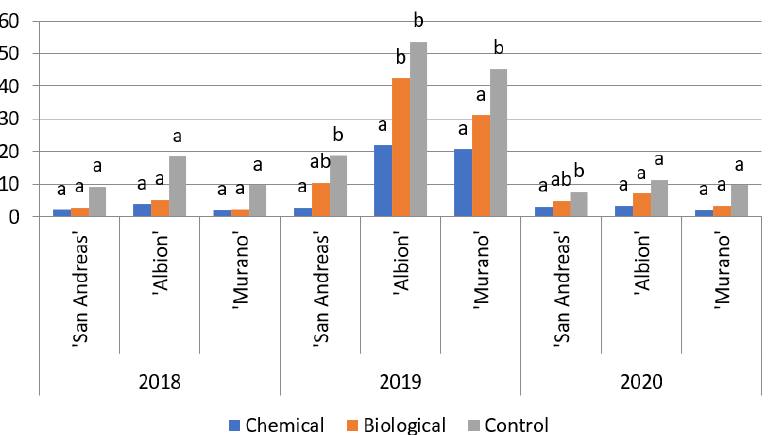
Figure 4. Percentage of fruit with symptoms of powdery mildew caused by Podosphaera macularis among fruit waste at harvest [%]. Bars on which the same letter follows within a cultivar for each year are not significantly different at p ≤ 0.05.